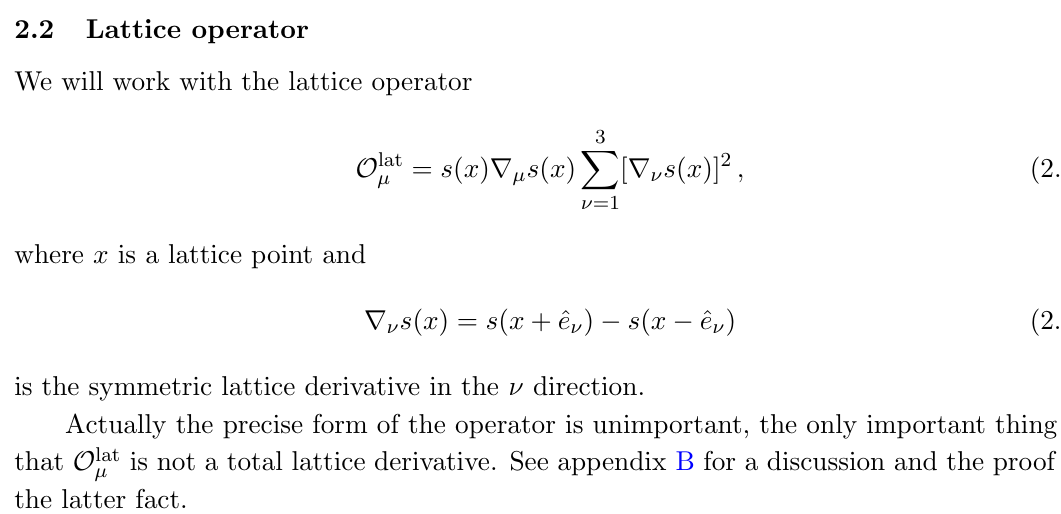
Figure 1 . The boundary conditions used in our simulation. The x a combination of free (white) and (cid:12)xed s = +1 (gray) boundary conditions. On the other faces the periodic boundary conditions are imposed. This drawing uses the Byzantine perspective only to improve visibility; the actual geometry is an L line is one possible location of the integrated observable